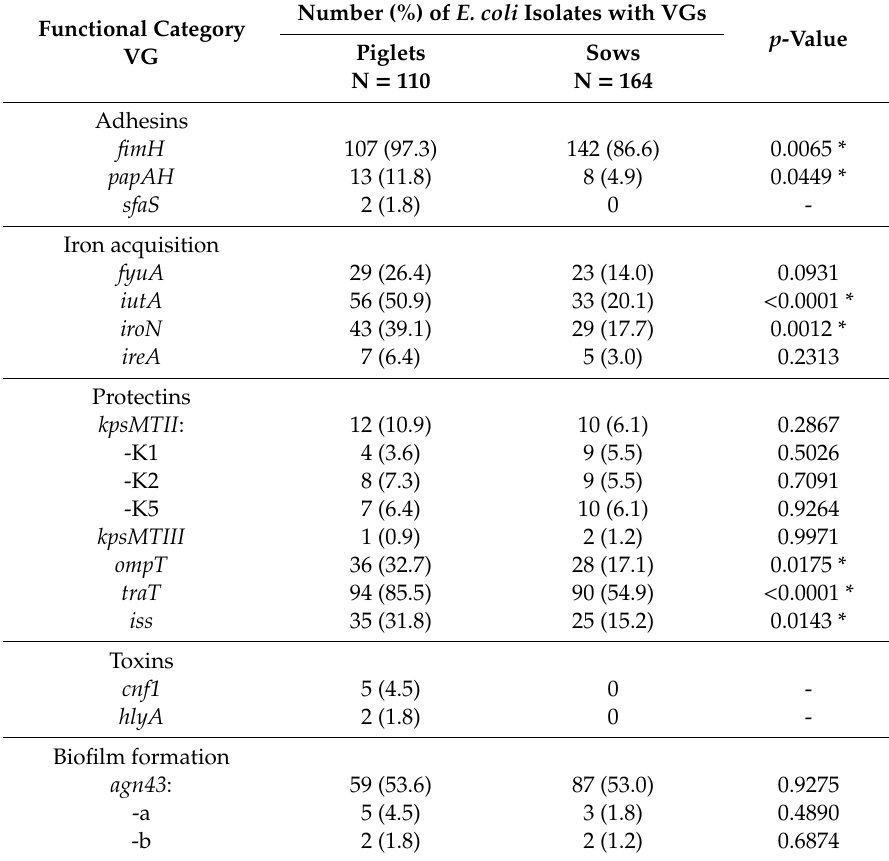
Table 1. Frequency of virulence genes (VGs) by functional categories among E. coli isolates from piglets and sows. The test of statistical significance for fixed e ff ect from the mixed logistic models with VG as the response and the animal as the independent